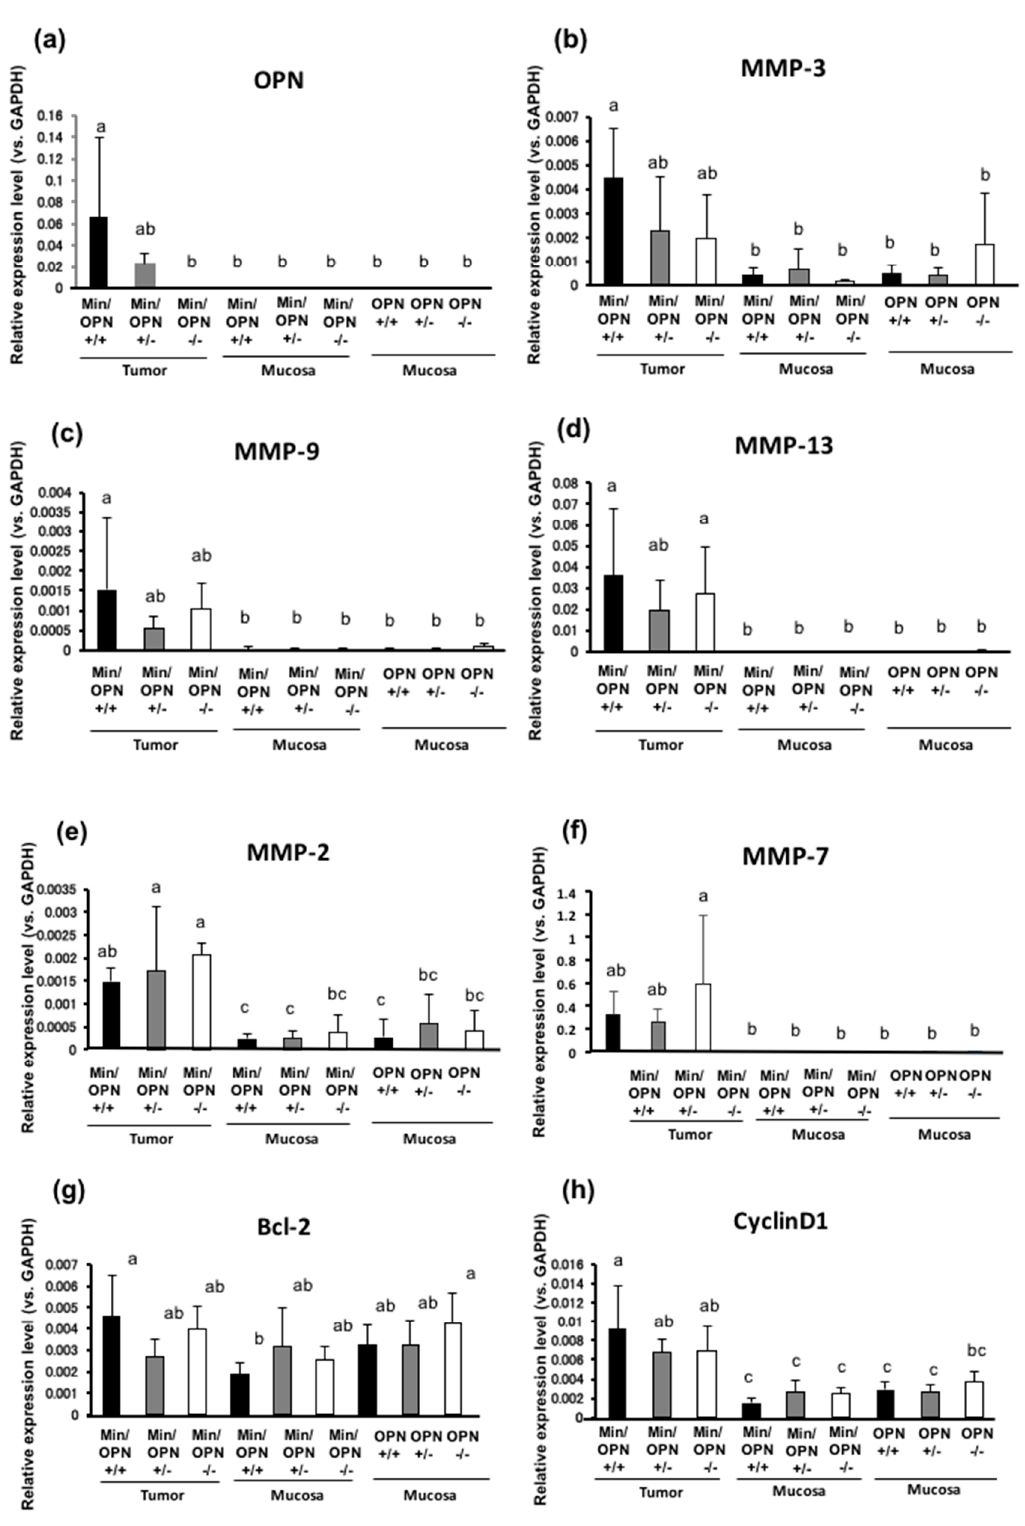
Figure 4. Figure 4. Cont .